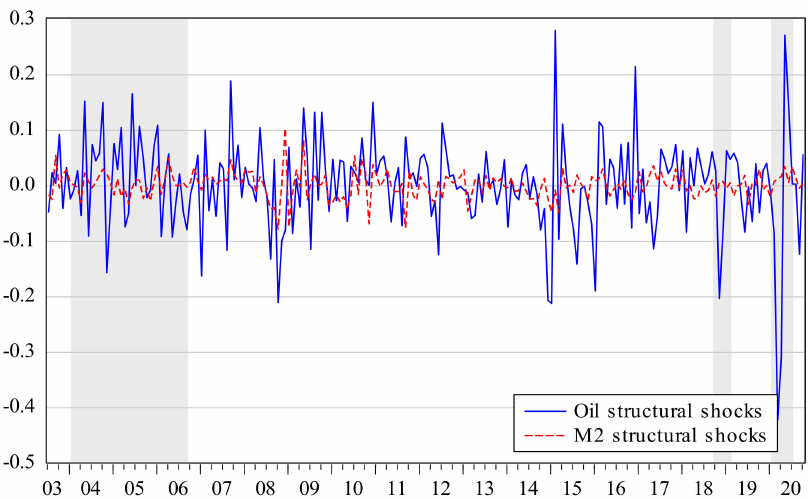
Figure 4. Dynamic characteristics identification of oil financial attribute. Note: There is a negative relationship between the monetary policy and the structural impact crude oil price, shown in shadow